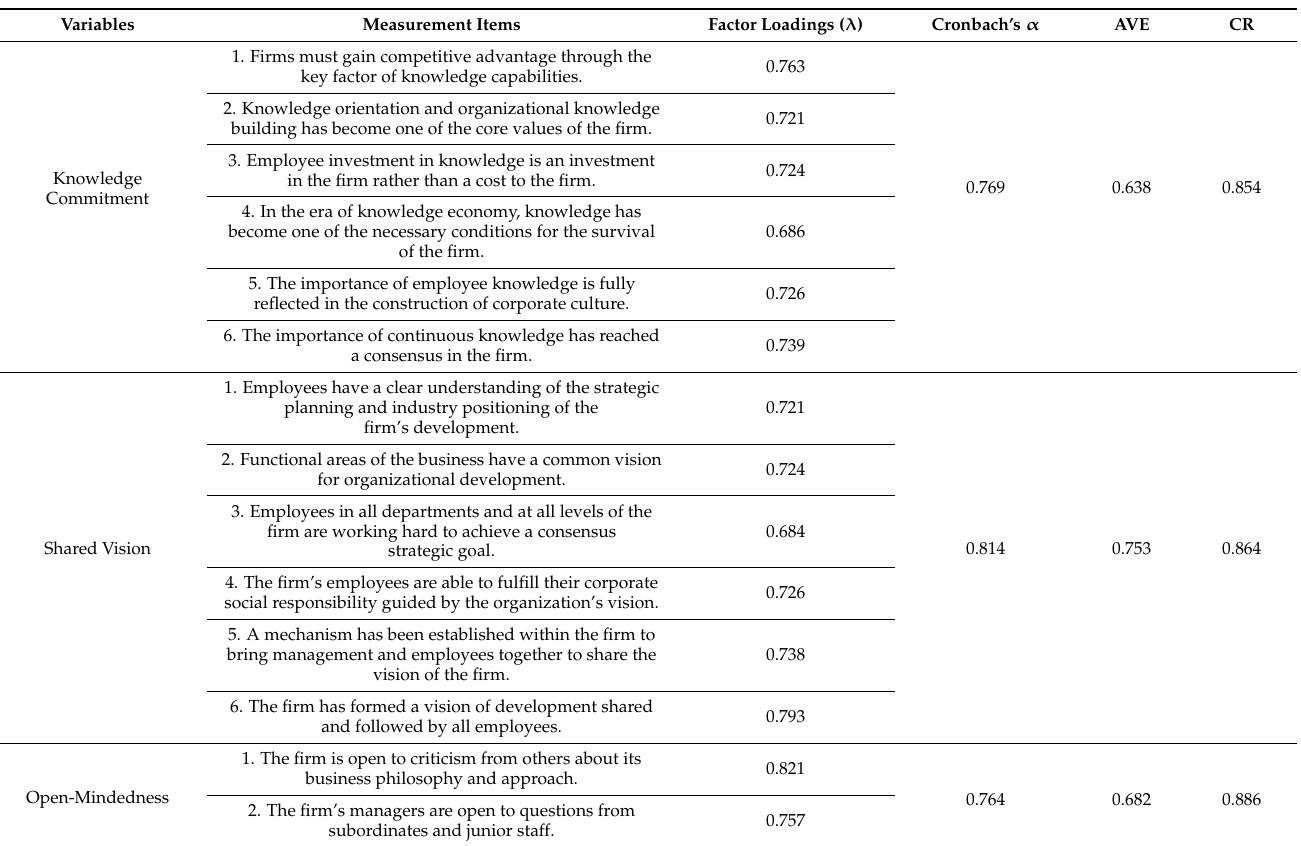
Table 2. Results of reliability and convergent validity